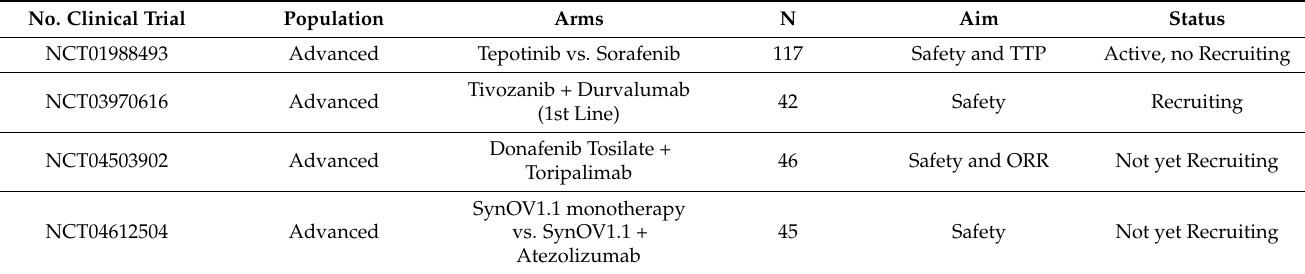
Table 2. Current phase I-II trials in intermediated/advanced